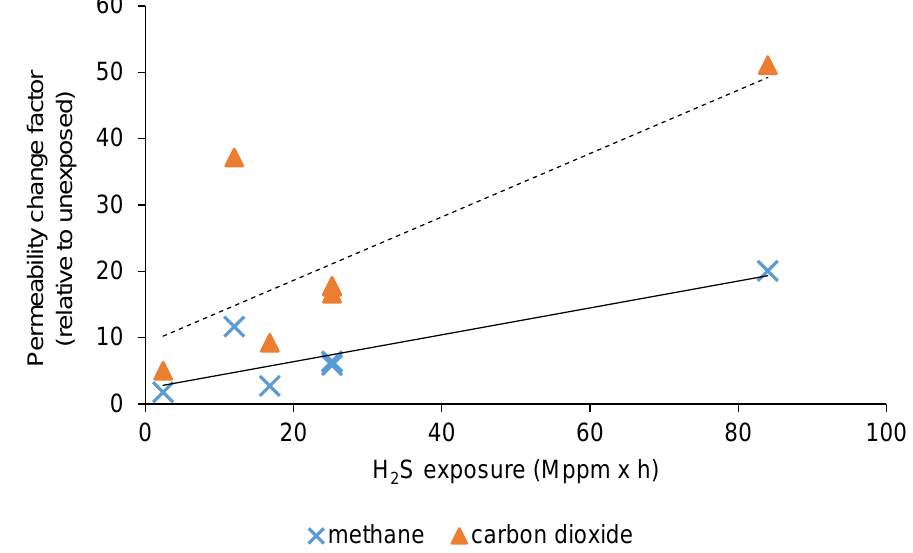
Figure 3. The layout of the experimental plan carried out in this study considering the conditions in Table 1.